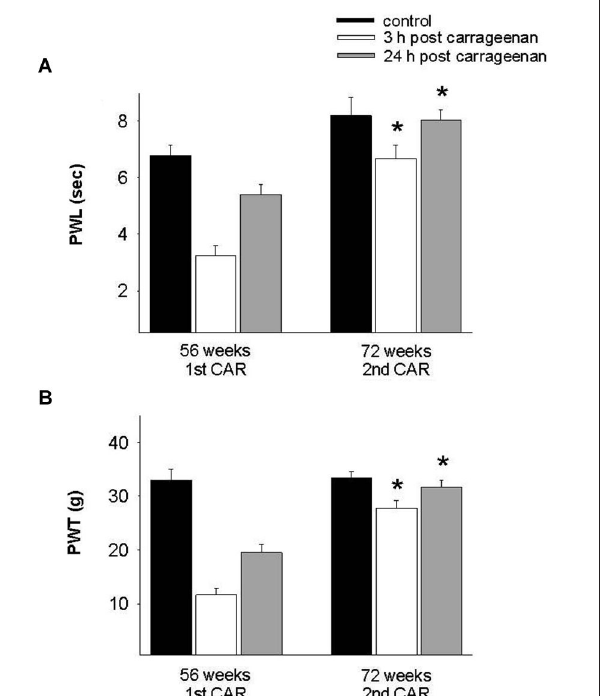
FIGURE 6 | Effect of repeated inflammation on nociceptive responses in old rats at 72 weeks of age. (A) In old rats, repeated CAR application at 72 weeks old causes a significant increase in PWL 3 h post-injection (white bars) as compared with values obtained after the first injection at 56 weeks ( F = 17.829, p = 0.001). (B) A similar effect is seen in the case of mechanociception ( F = 36.099, p = 0.001). * p = 0.001, compared 3 h post CAR between 56 and 72 weeks (white bars). Data are expressed as mean ±